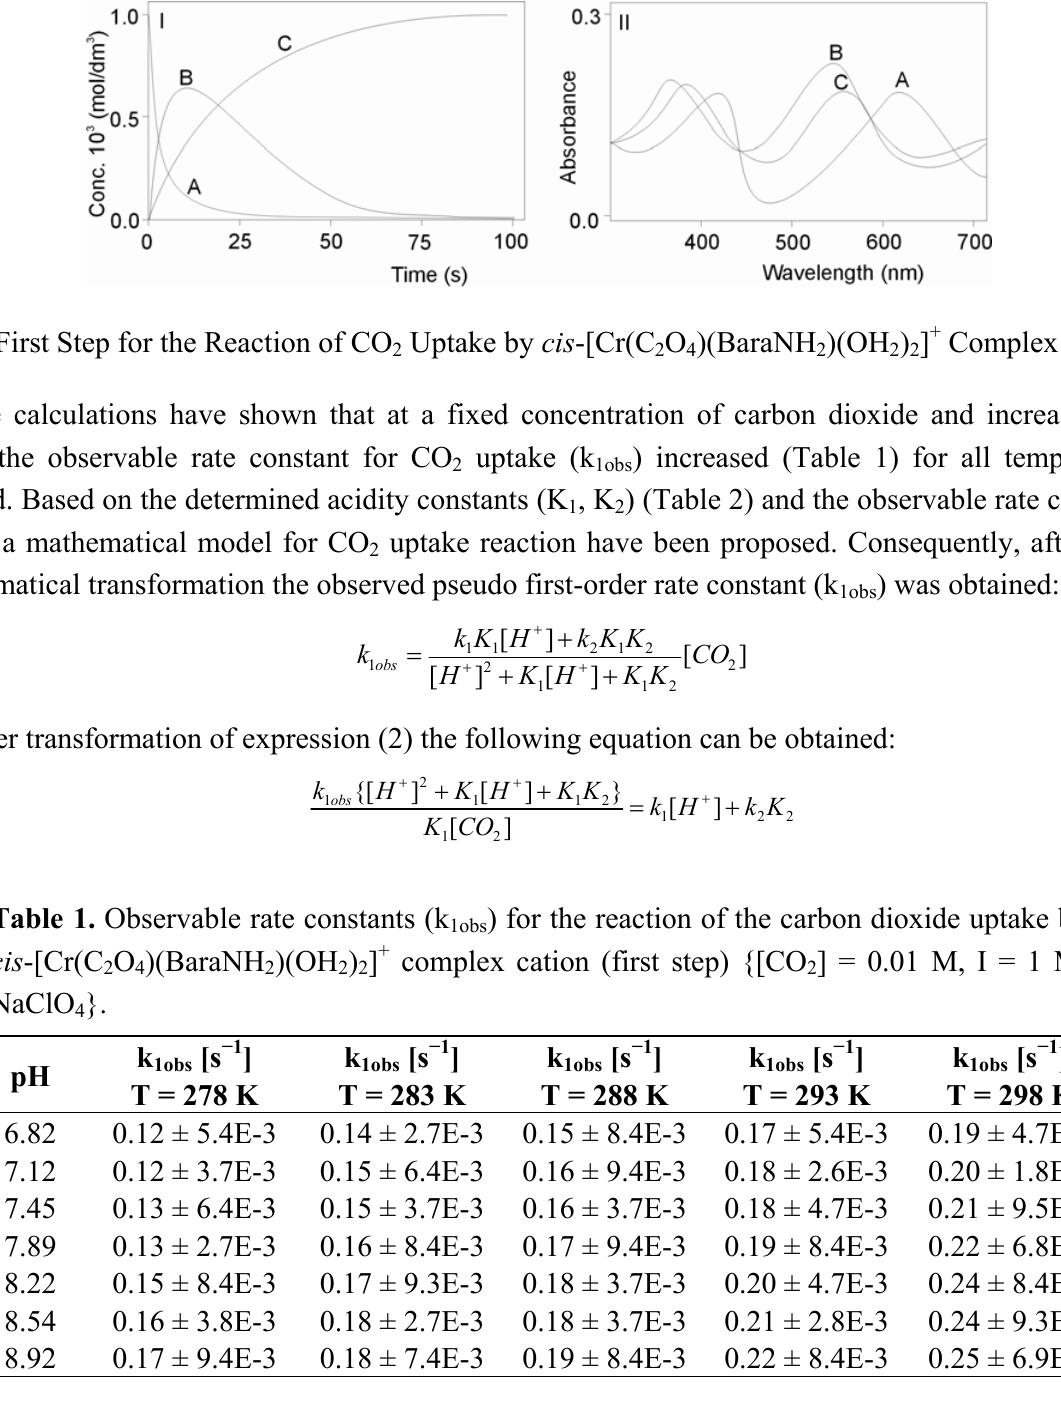
O )(BaraNH )(OH ) ] + cation and 2 4 2 2 2 O )(BaraNH )(CO )] − anion and intermediate product 2 4 2 3